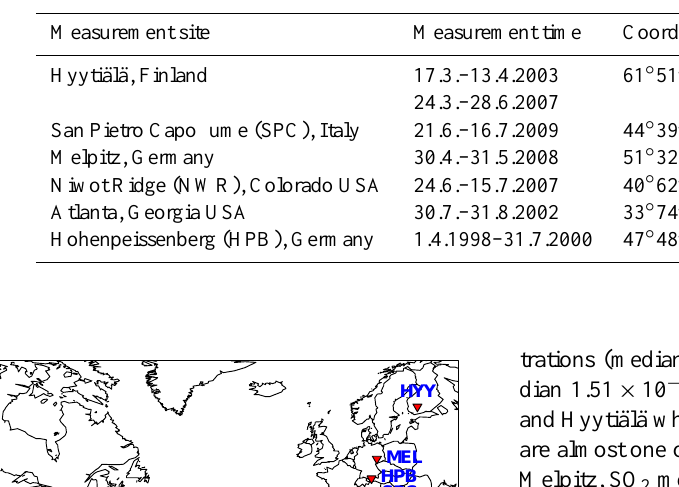
Table 1. Measurement places and times of the campaigns.